Question: Produce a descriptive caption suitable for publication.
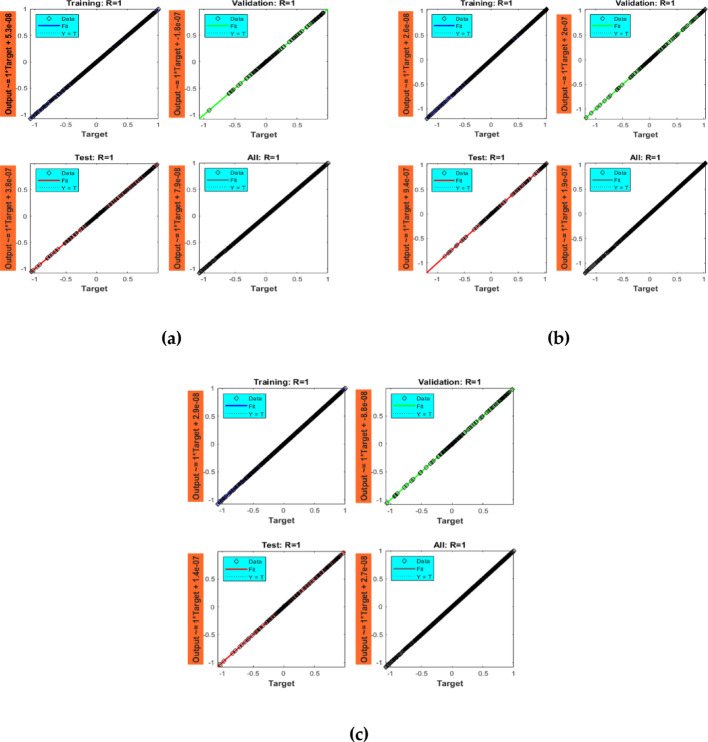
Answer: a-c Regression analysis for ANN design (Scenarios 1–3)